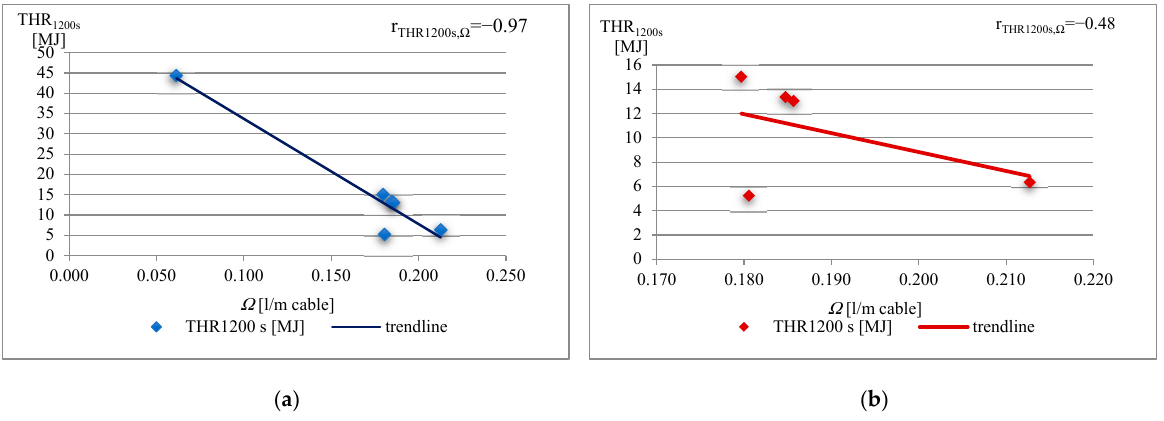
Figure 4. Correlation between THR 1200s and Ω for the tested cables.